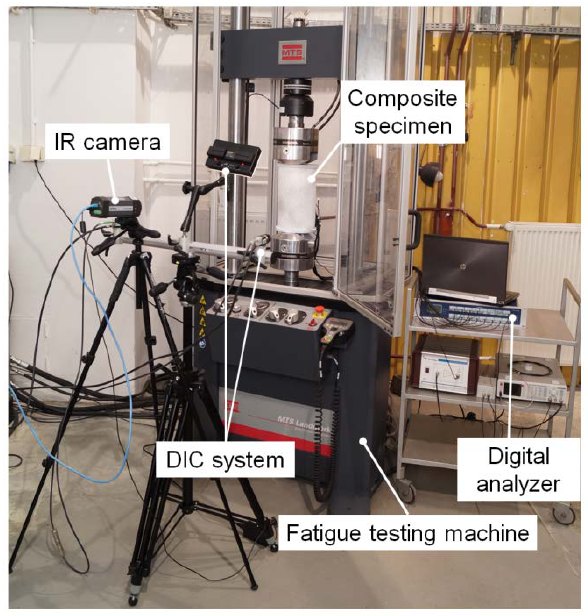
Figure 1. Fatigue-testing machine with equipment for damage-growth monitoring.